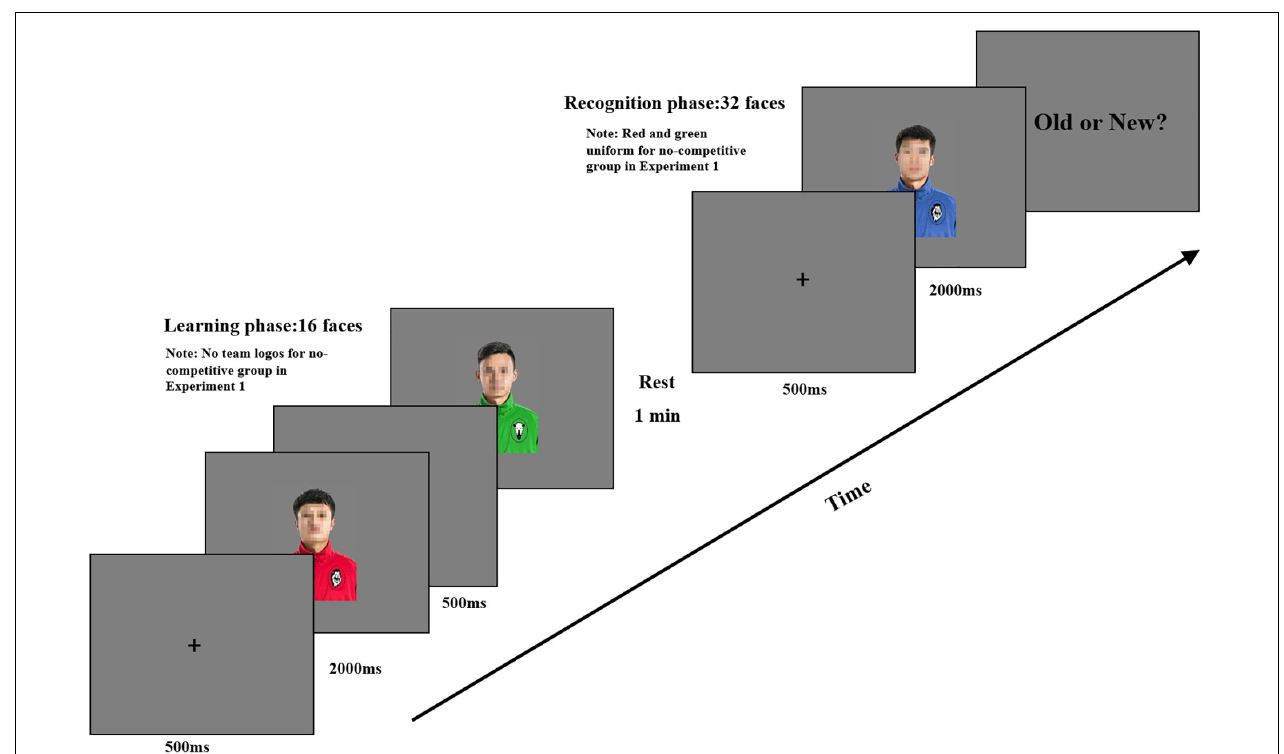
FIGURE 1 | The procedure for competitive group in Experiment